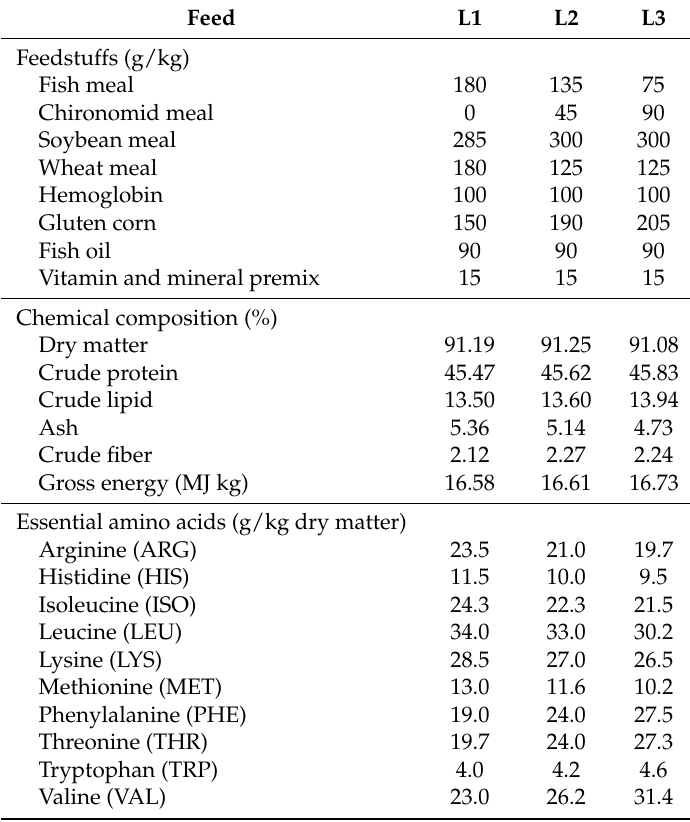
Table 3. Formulation, proximate composition, and essential amino acids of the three diets used in the trial. Feed L1 L2 L3 Feedstuffs (g/kg) Fish meal 180 135 75 Chironomid meal